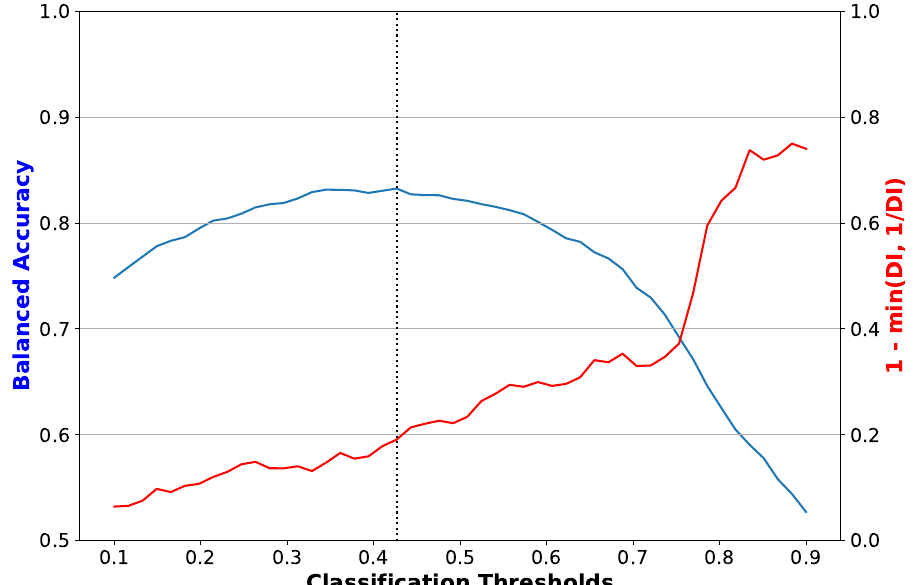
Figure 2. Balanced accuracy and disparate impact error versus classification threshold for a logistic regression classifier with no bias mitigation. The dotted vertical line is the threshold that maximizes balanced accuracy. The plot shown corresponds to one of the folds of cross-validation. Disparate impact error, equal to 1- min (DI, 1/DI), where DI is the disparate impact, is the difference between disparate impact and its ideal value of 1.